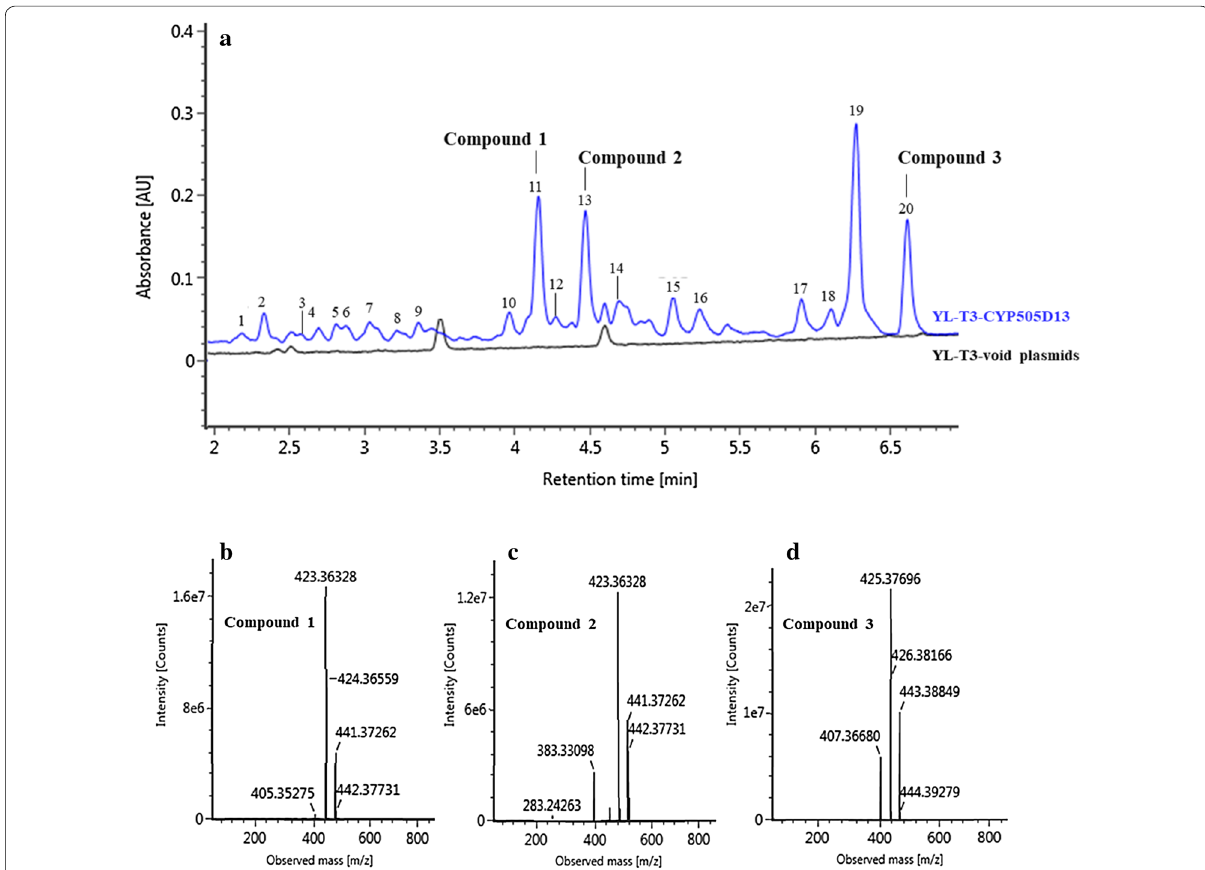
Fig. 1 UPLC-MS analysis of 96 h fermentation extract of YL-T3-CYP505D13. a UPLC analysis of extracts of YL-T3-CYP505D13 (blue line) and the control strain (black line); b – d MS spectra of compound 1, compound 2 and compound 3 as indicated in